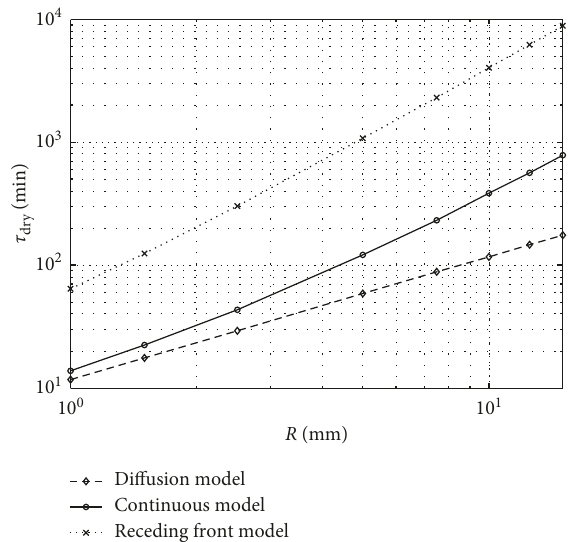
Figure 11: Influence of sample size: drying time versus sample size.